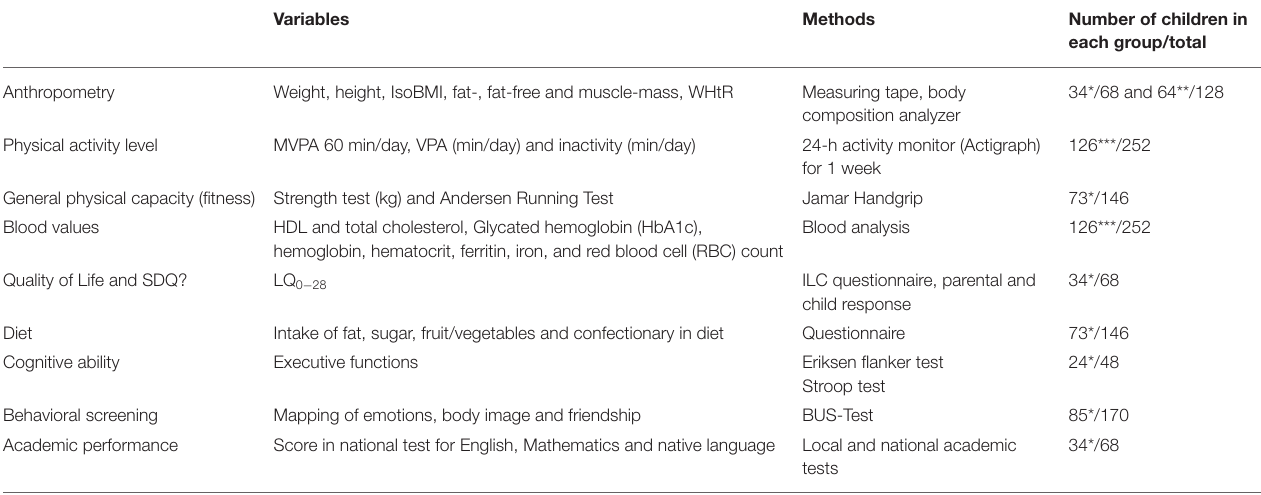
TABLE 1 | Based on the various tests, the following sample sizes for each group (intervention and control schools) were calculated as adequate for analyses, with a power of 80% and alpha of 5%.